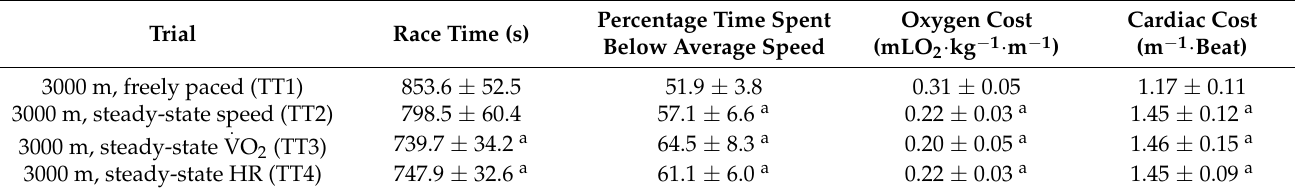
Table 1. Summary of the participants’ performance and physiological